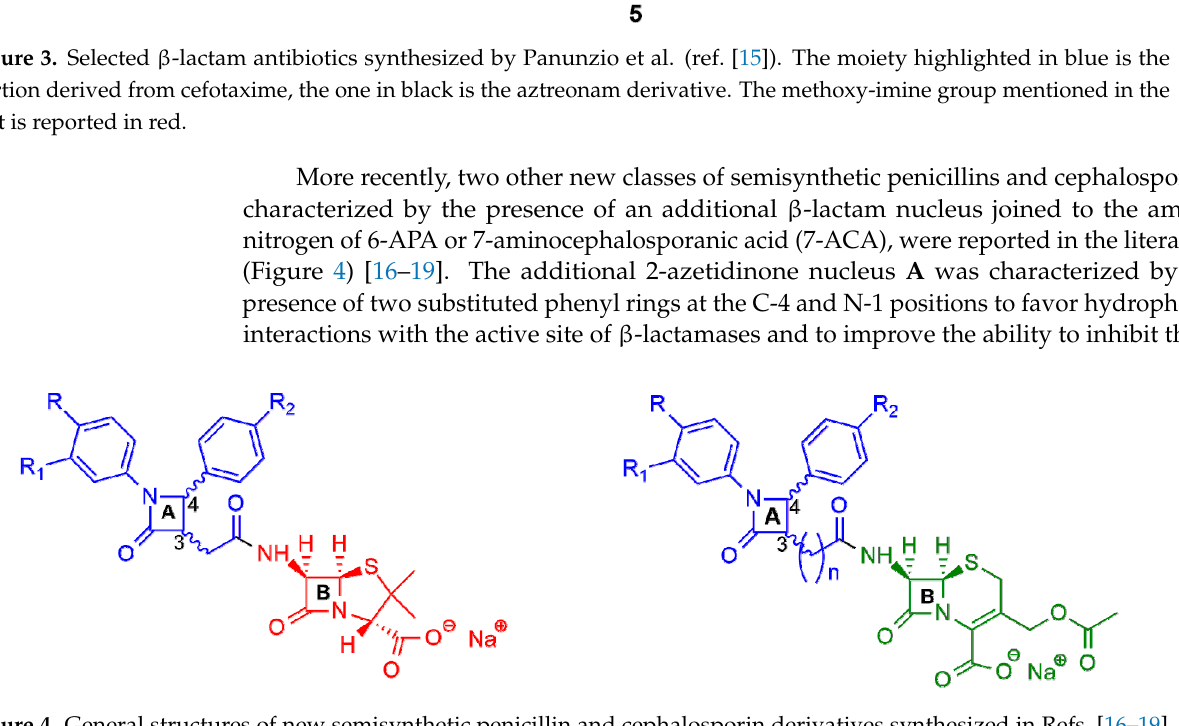
Figure 4. General structures of new semisynthetic penicillin and cephalosporin derivatives synthesized in Refs. [16–19]. On the left, the penicillin nucleus is shown in red; on the right, the cephalosporin nucleus is shown in green. For nucleus A, the stereochemistry is not defined because it is synthesized as a racemic 3,4-trans- β -lactam.